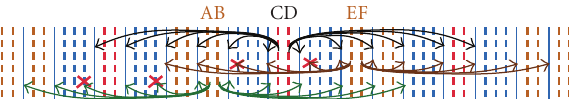
Figure 17: Coulomb transitions of nearest hole pair at ν = 4 / 13.